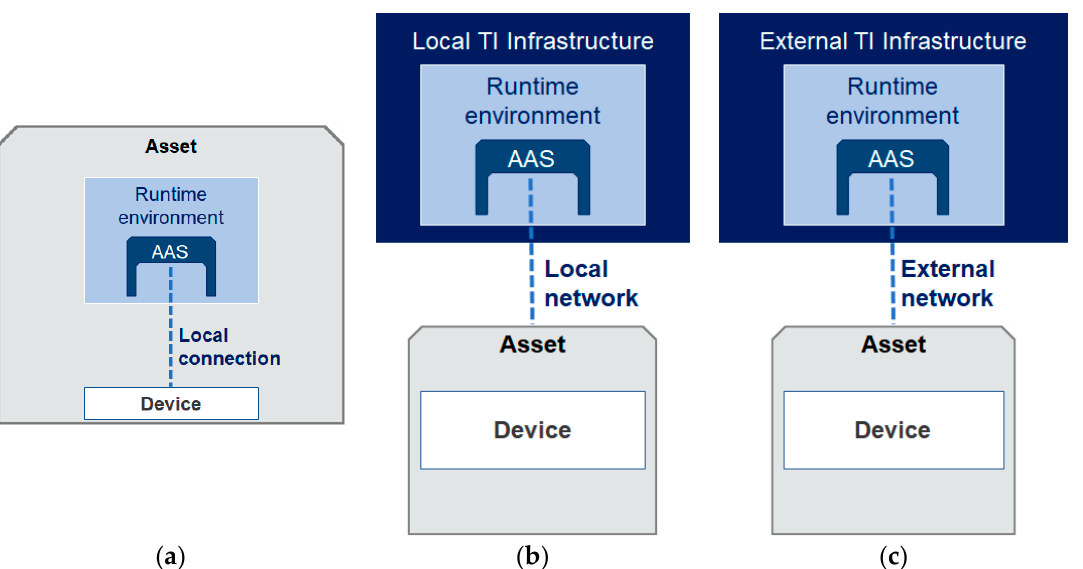
Figure 2. Computing platform perspective for implementation of the AAS: ( a ) edge, ( b ) fog, ( c ) cloud. Adapted from [42] with permission from the Federal Ministry for Economic Affairs and Climate Action. Scharnhorststraße 34–37, 10115 Berlin.